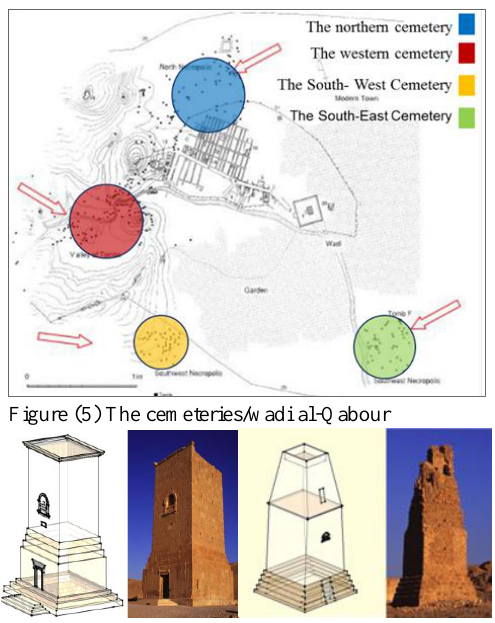
Figure (6) Tower tomb of Ellabell & Tower tomb of Atenatan Tower tomb of Ellabell : Four stories high about 20 meters high.